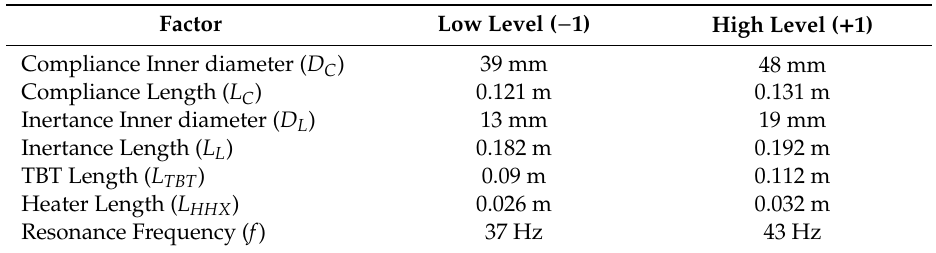
Table 3. Factors and levels for 2 7 factorial